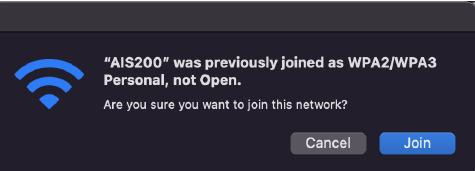
Figure 2. Warning issued when attempting connection to a rogue AP with no encryption